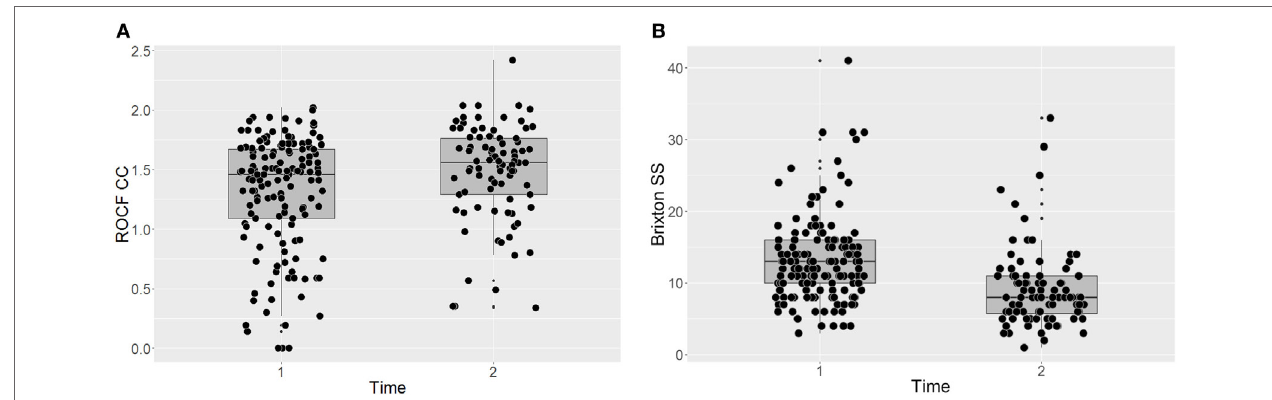
FigUre 1 | Task-based assessments of central coherence ( a ) and set-shifting ( B ) before and after CRT. ROCF, Rey-Osterrieth Complex Figure test; CC, central coherence; SS, set-shifting; Dflex, Detail and Flexibility Questionnaire; CRT, cognitive remediation therapy; Time 1, before cognitive remediation therapy; Time 2, end of cognitive remediation therapy.